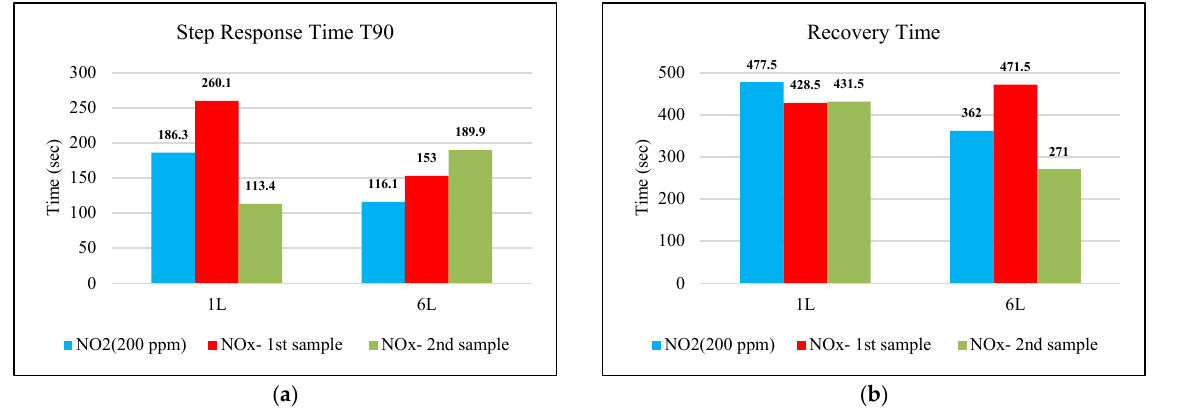
Figure 21. ( a ) SGP41 step response time T90 for NOx gases, ( b ) SGP41 recovery time for NOx gases. The step response time (T90) and the recovery time for the SGP41 VOC-Index and the BME688 IAQ-Index for several selected VOC solvents with the same volume (100 µ L) with a fixed distance between the sensor node and the VOC source of 40 cm are presented in Figure 22a,b, respectively.